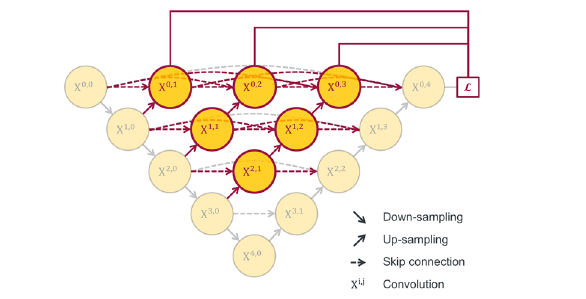
Figure 2 . U-Net++ architecture (Zhou et al.,